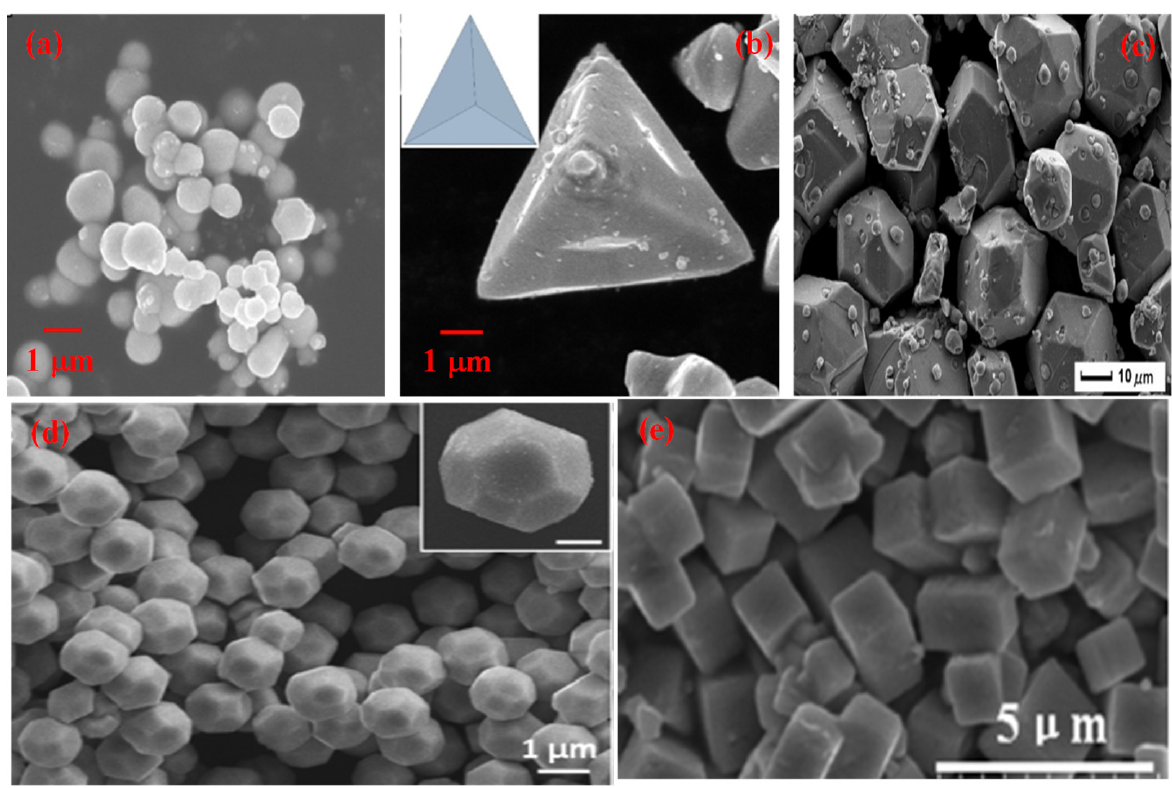
Figure 7. SEM micrographs of different morphologies of Ag 3 PO 4 ( a ) Sphere (Reprinted with permis- sion from [141]. Copyright 2018 Elsevier), ( b ) Tetrahedral (Reprinted with permission from [142]. Copyright 2018 Elsevier), ( c ) Polyhedral (Reprinted with permission from [137] Copyright 2013 American Chemical Society), ( d ) Dodecahedral (Reprinted with permission from [143]. Copyright 2017 American Chemical Society), ( e ) Cubic (Reprinted with permission from [144]. Copyright 2015 Elsevier). Table 4. Details of different morphologies of nanostructured Ag 3 PO 4.